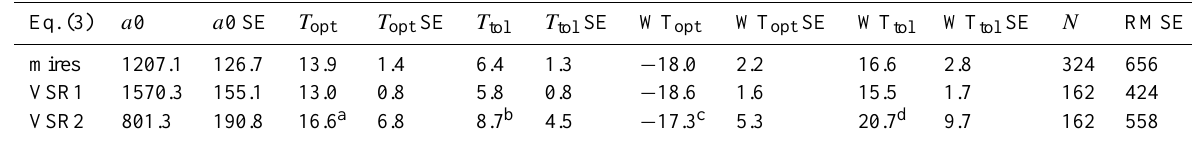
Table 3. Parameter estimates and their standard errors for trend coefficients of CH 4 fluxes (µgm − 2 h − 1 ) of the mires (VSR1, VSR2, Eq. 3). Equation (3) is a function of water table depth (cm) and soil temperature at a depth of 5cm ( ◦ C). Eq.